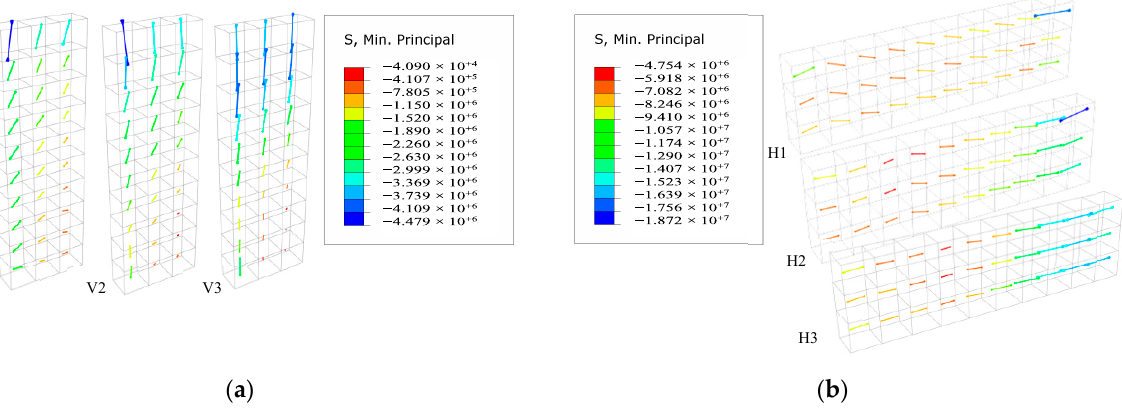
Figure 23. Compressive stress vector diagram of the shear key: ( a ) shear key B; ( b ) shear key E. (unit: Pa)